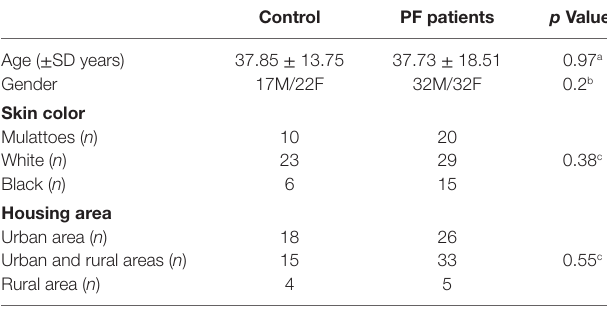
Table 1 | Gender, skin color, and housing area of fogo selvagem patients and their control